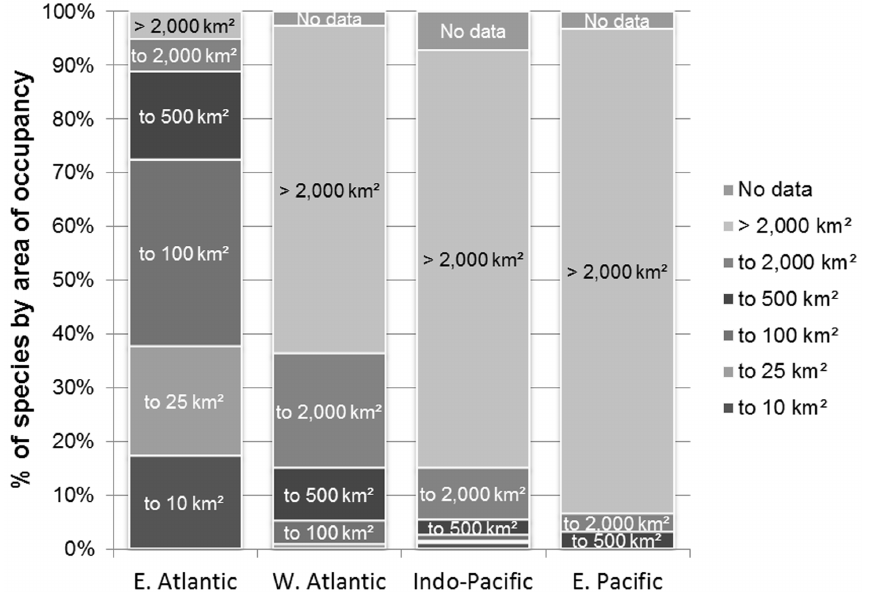
Figure 6. Main threats to Conus by ocean basin. The number of Conus species at risk (consolidation of CR, EN and VU) indicating primary causes of endangerment, being demersal fishing, tourism, shell collecting, ports and harbours, petro-chemical spills, elevated sea-surface temperatures, effluent discharge and runoff, and coastal development.